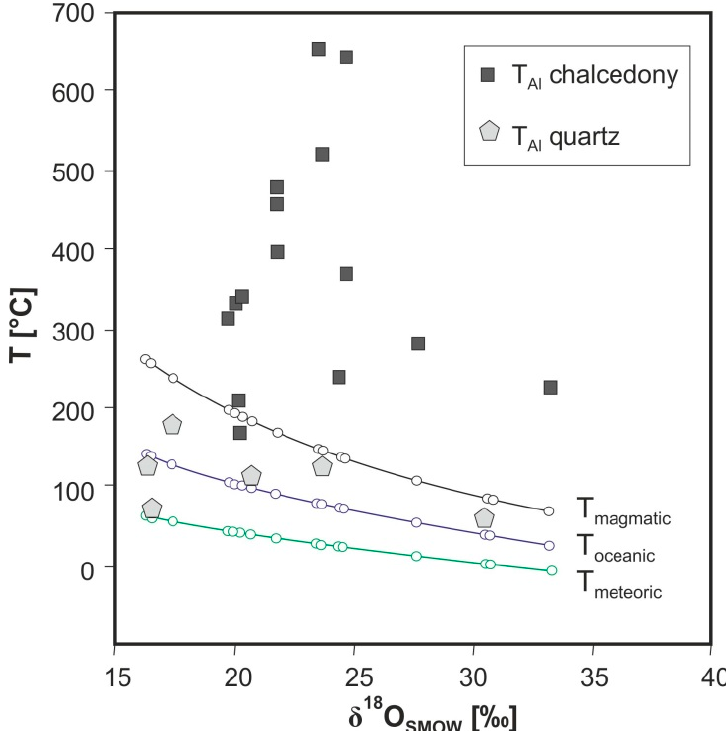
Figure 27. Temperatures of agate formation calculated from [AlO 4 ] 0 concentrations in chalcedony (T Al chalcedony) and macrocrystalline quartz (T Al quartz) compared to temperatures obtained for the same agate samples assuming oxygen isotope equilibration with meteoric (T meteoric ), oceanic (T oceanic ) or magmatic water (T magmatic ); data from Götze et al. [185].